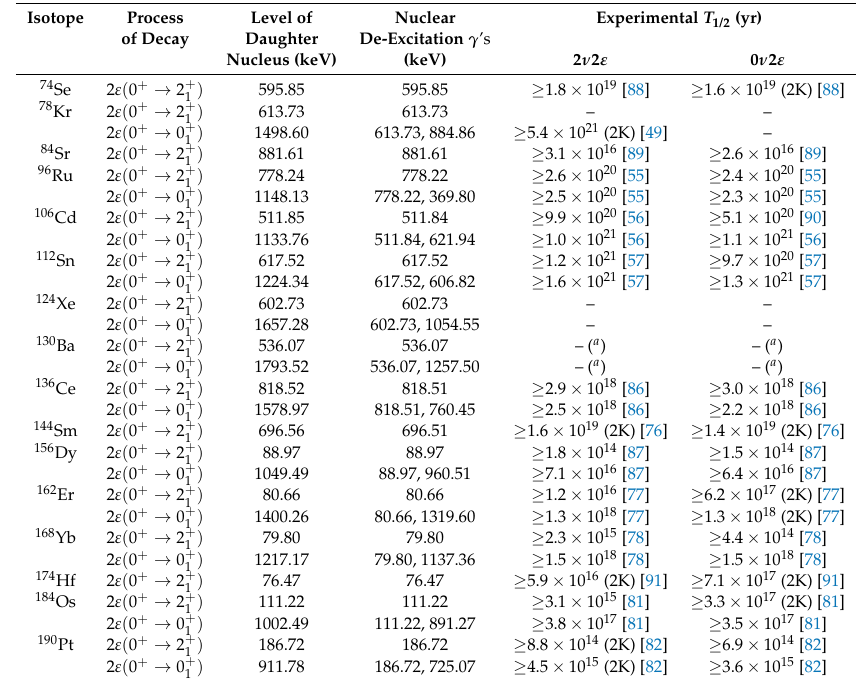
Table 7. Some of the isotopes most considered in the field of the 2 ε decay (2 ν and 0 ν ) to the excited levels of daughter nuclei. When available, the present best experimental result on T 1/2 is also reported (limits are at 90% C.L.). Only the transitions to the first 2 + and 0 + excited levels of the daughter nucleus, if energetically allowed, are considered. See text.